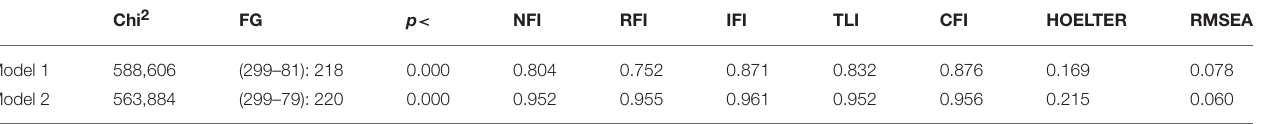
TABLE 3 | Models of structural linear results of the variables.